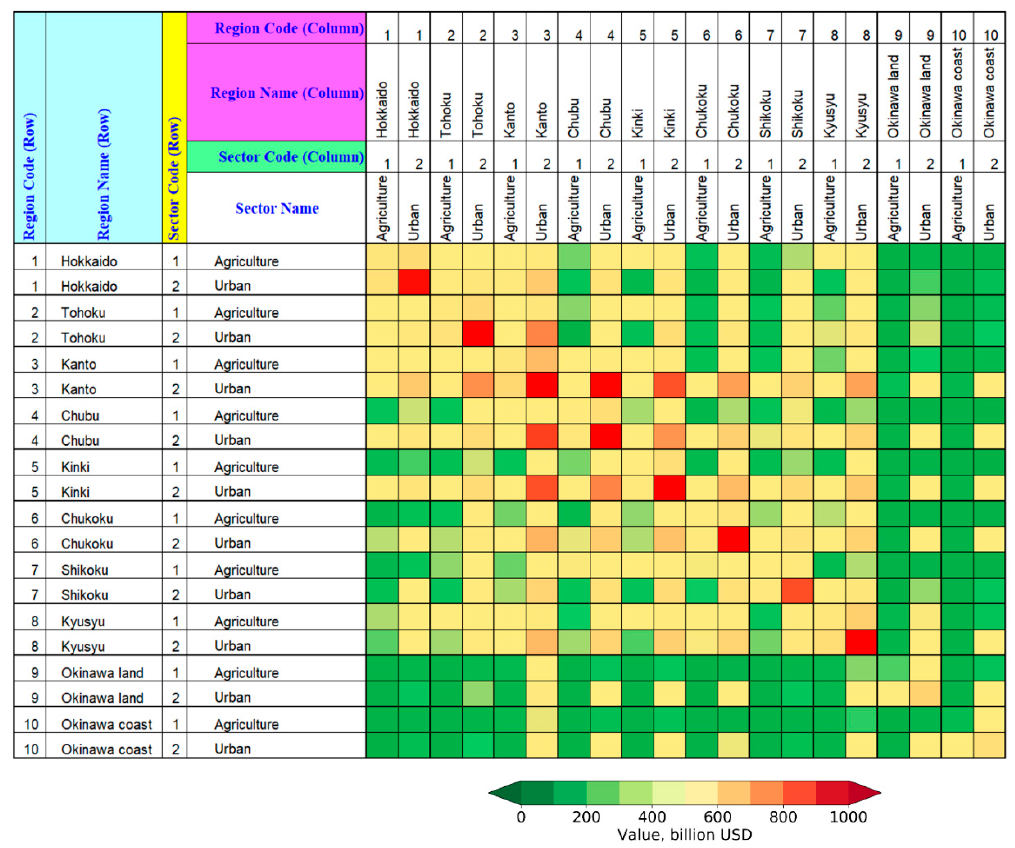
Figure 10. Multi-regional-input-output (MRIO) table originally established from this study and used